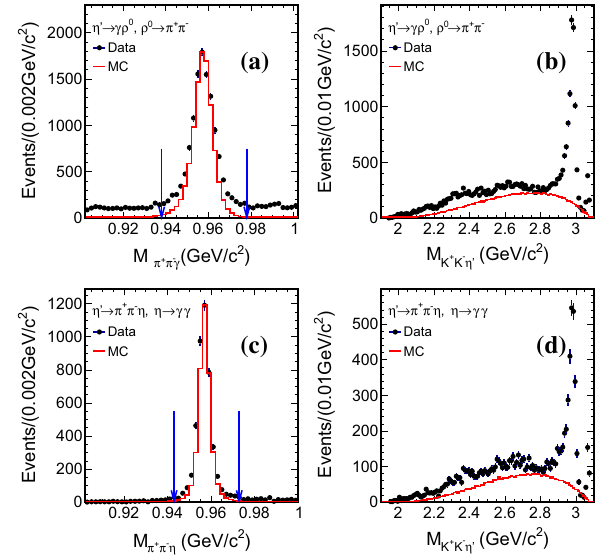
Fig. 1 Invariant-mass distributions for the selected candidates of J /ψ → γ K + K − η (cid:3) . Plots a , b are invariant-mass distributions of γπ + π − and K + K − η (cid:3) for η (cid:3) → γρ 0 , ρ 0 → π + π − , respectively; plots c , d are the invariant-mass distributions of π + π − η and K + K − η (cid:3) for η (cid:3) → π + π − η , η → γγ , respectively. The dots with error bars correspond to data and the histograms are the results of PHSP MC simulations (arbitrary normalization)